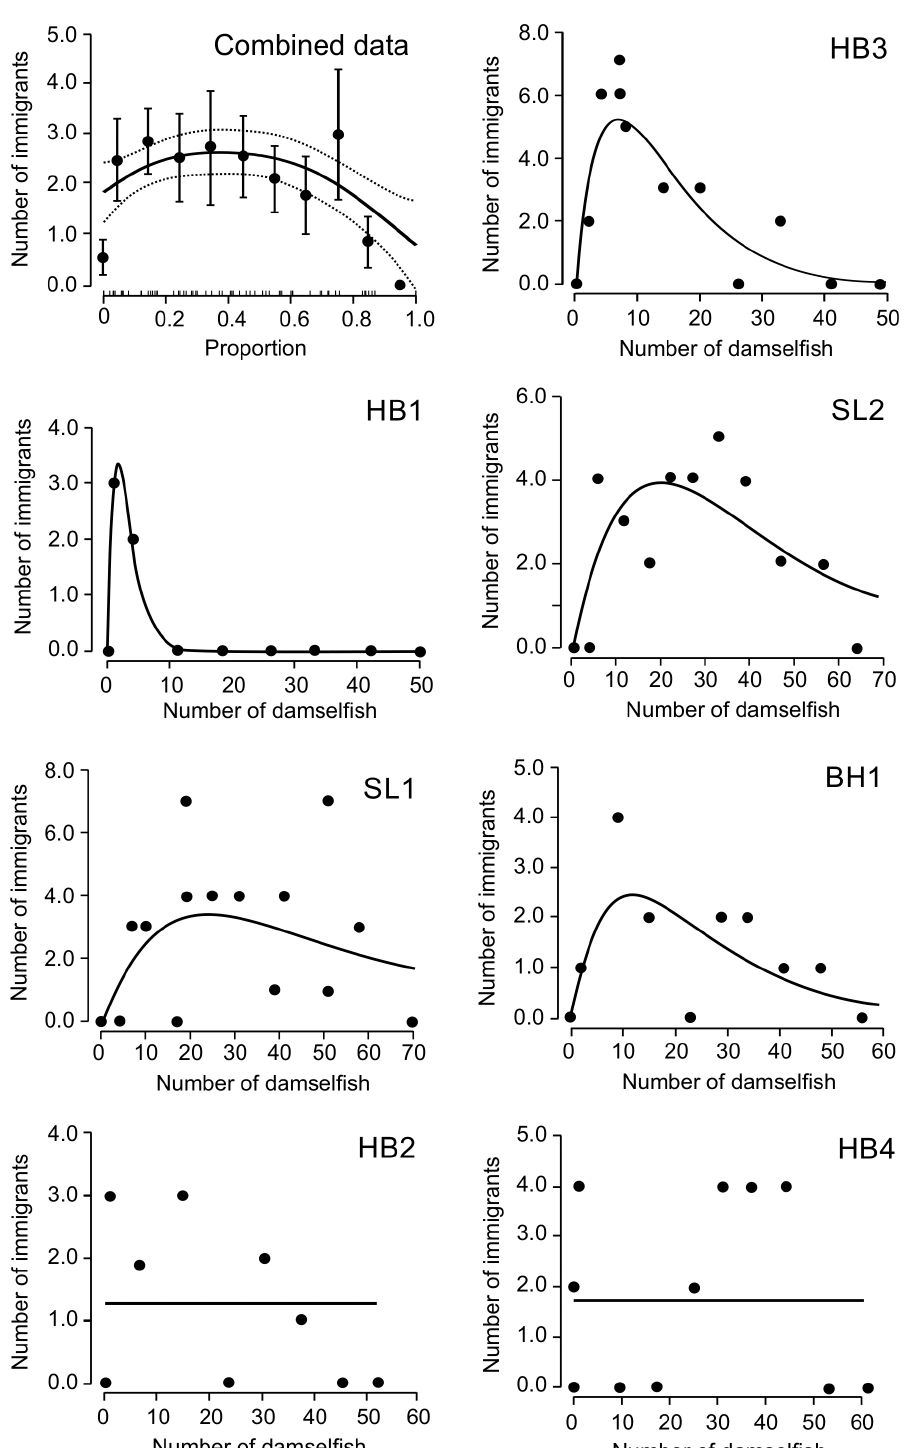
Fig 1. Immigration rate (per site scaling) in relation to density. Relationship between the number of damselfish on a site after a removal event and the number of immigrants that arrived following that removal (site scaling) for each individual site and for all sites combined (upper left panel). Individual sites are ordered by strength of support for a hump-shaped function starting with the upper right panel and identified by abbreviations (Bachelor Hall Reef: BH1; Heron Bay Reef: HB1, HB2, HB3, HB4; Sandy Lane Reef: